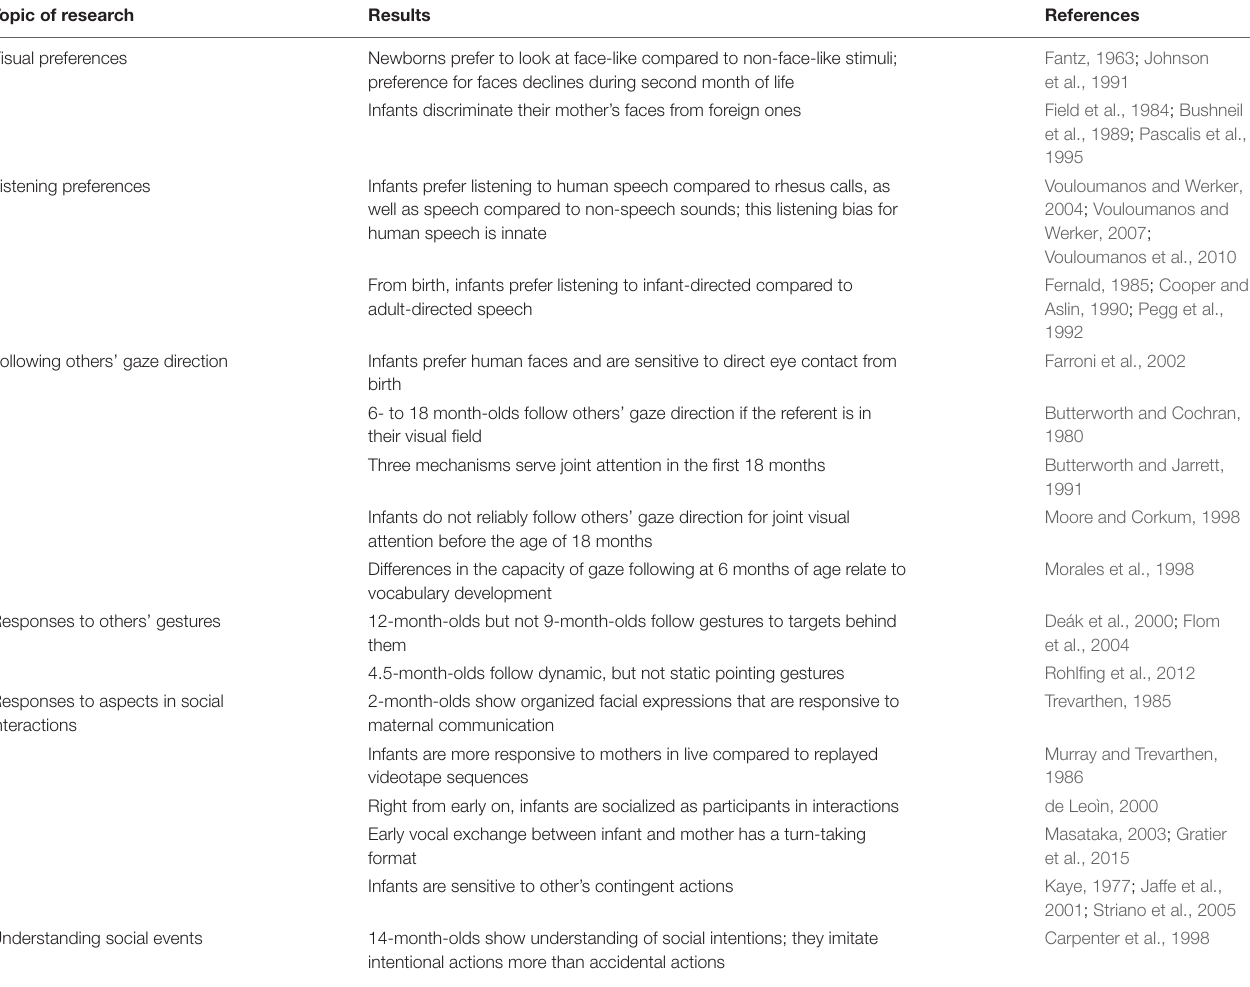
TABLE 2 | State of research on social sensitivity in